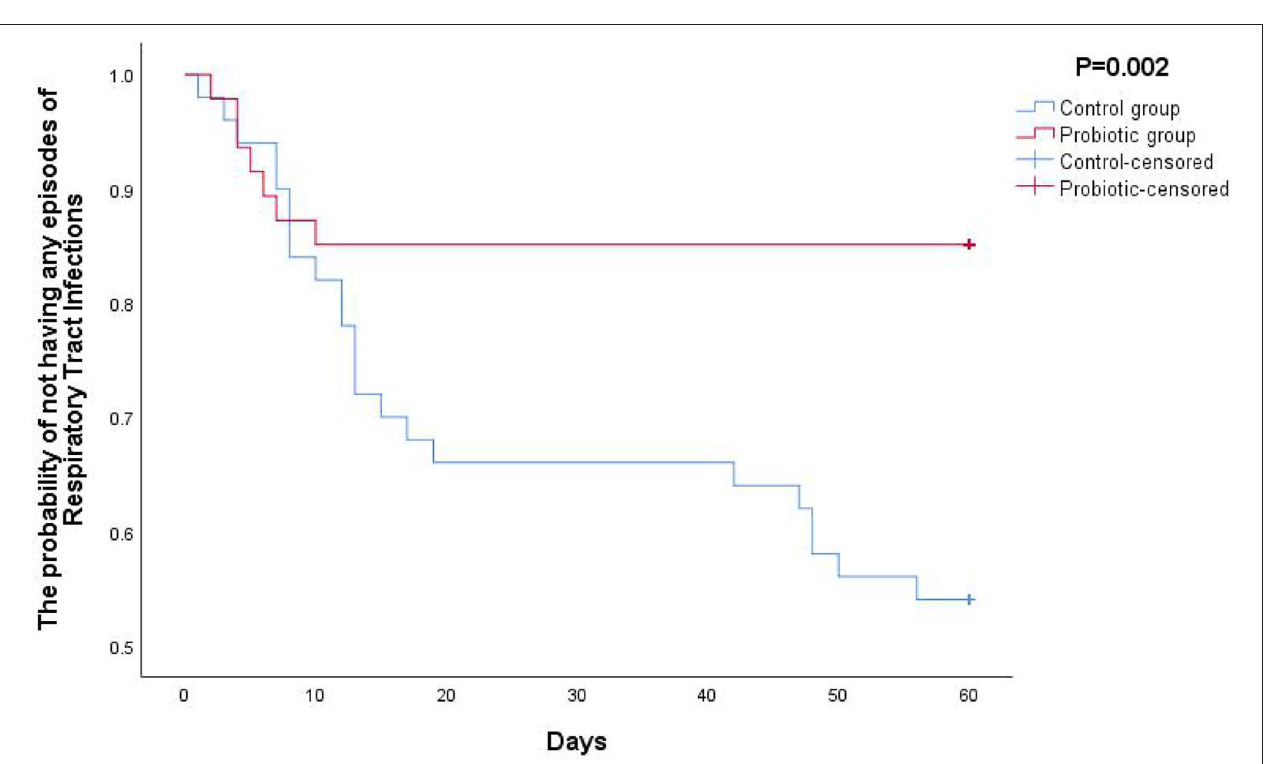
FIGURE 1 | The Kaplan–Meier curve of probability of not having any episodes of respiratory tract infections.